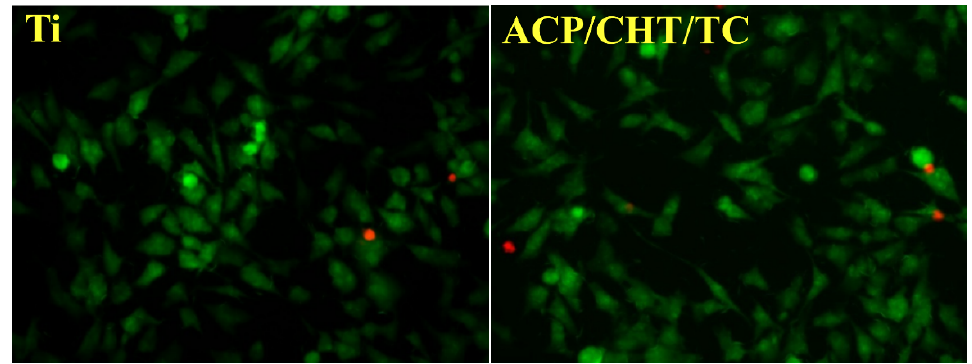
Figure 12. Fluorescence microscopy images of MG63 cells grown after 24 h on as-deposited composite films ( right ) and on Ti control disks ( left ), respectively. Staining with PI and FDA (magnification × 200).